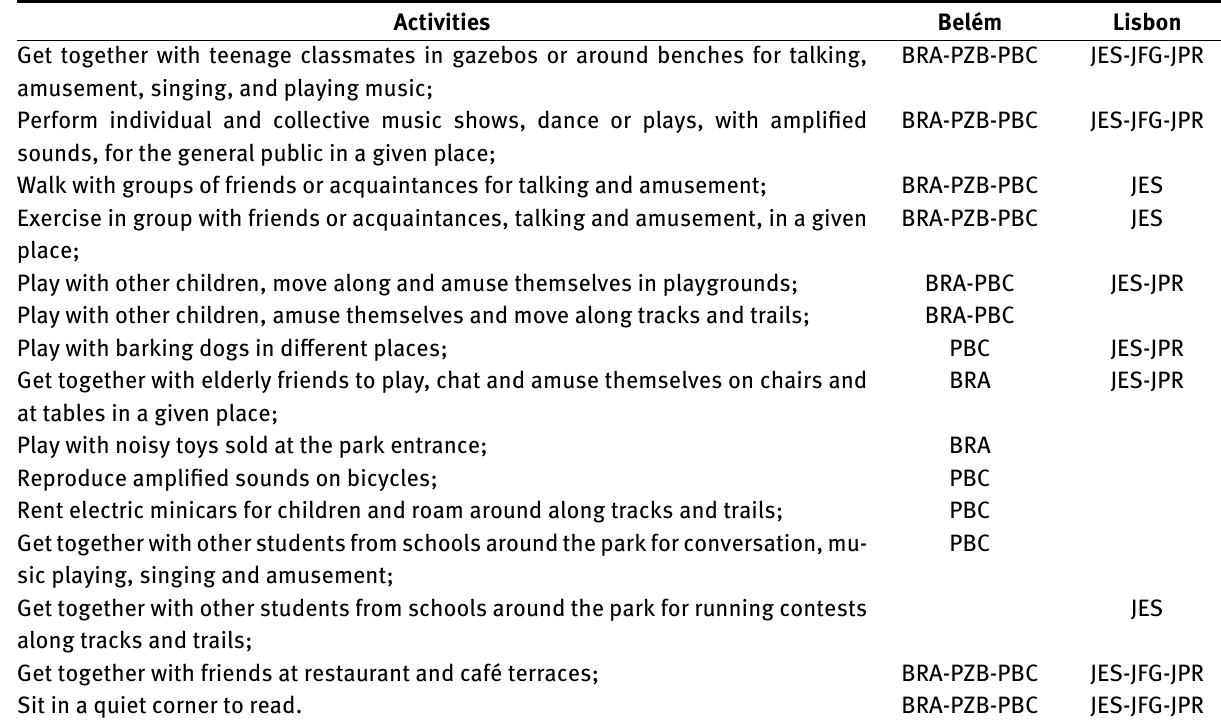
Table 4: Leisure activities in parks in Belém and